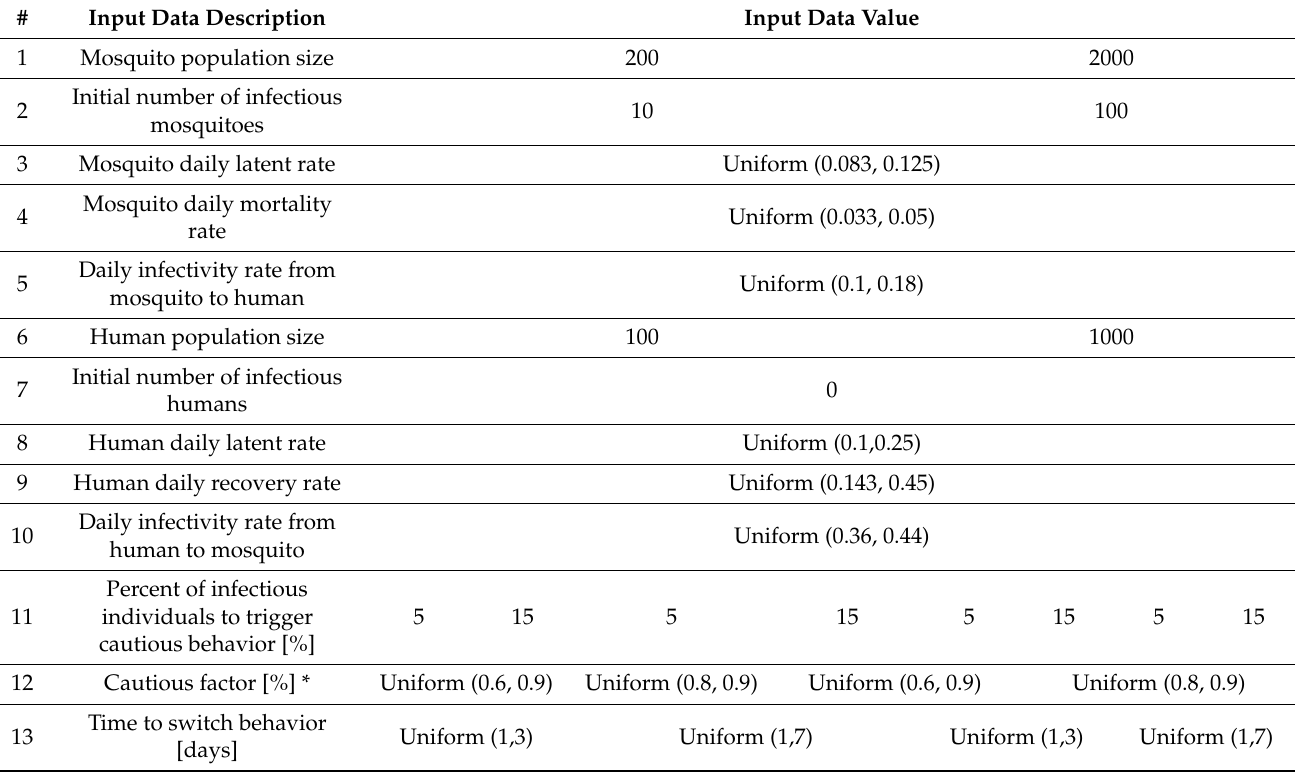
Table 6. Input parameter values of the simulation Model